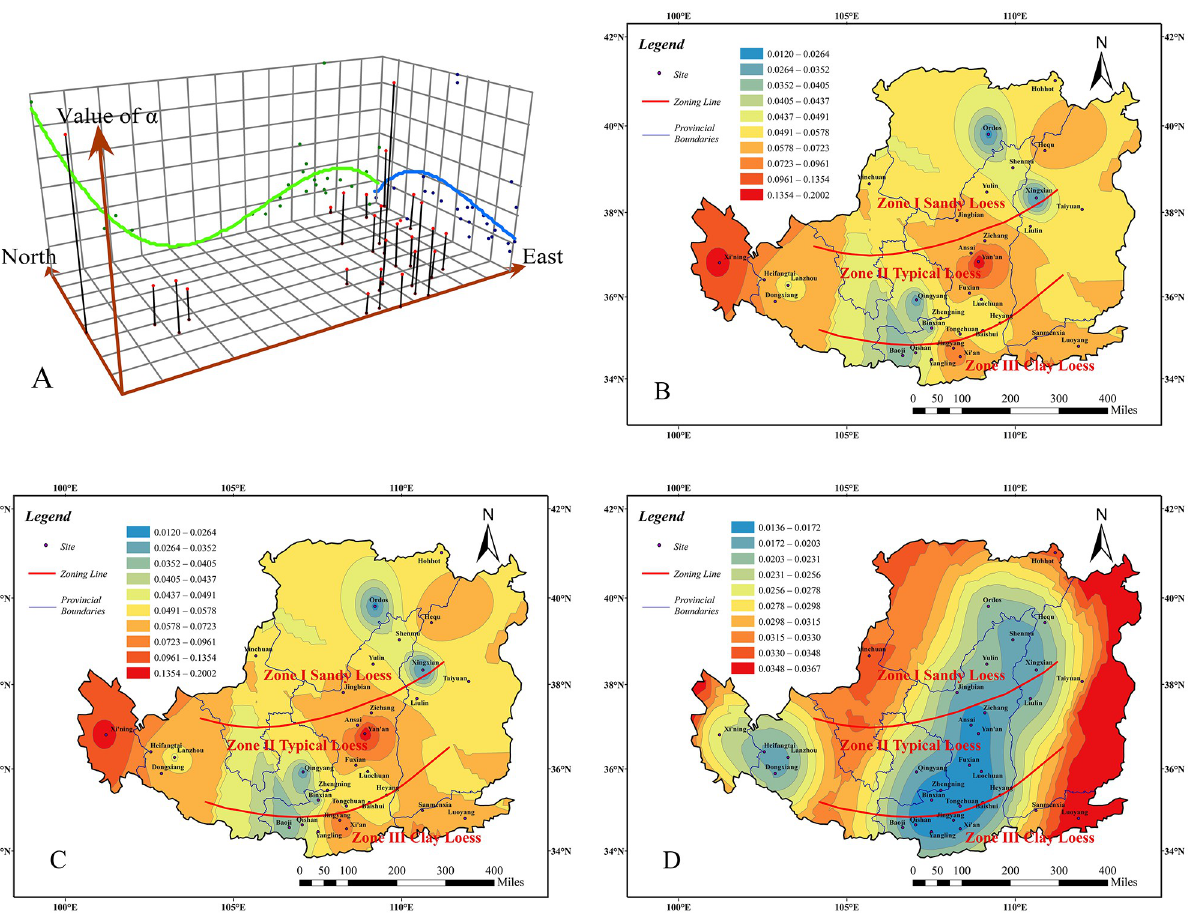
Fig 3. Analysis result of parameter α . Trend analysis graph(A). measured value contour graph(B). prediction value contour graph(C). prediction standard error value graph(D) (Only the boundary of the Loess Plateau comes from Huang [32], illustrative purposes only).